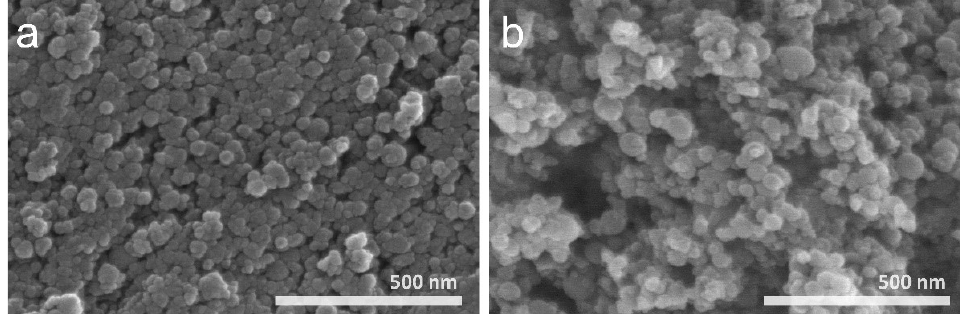
Figure 7. FE-SEM images of nanopowder synthesized in ( a ) Run 5 and ( b ) Run 6.